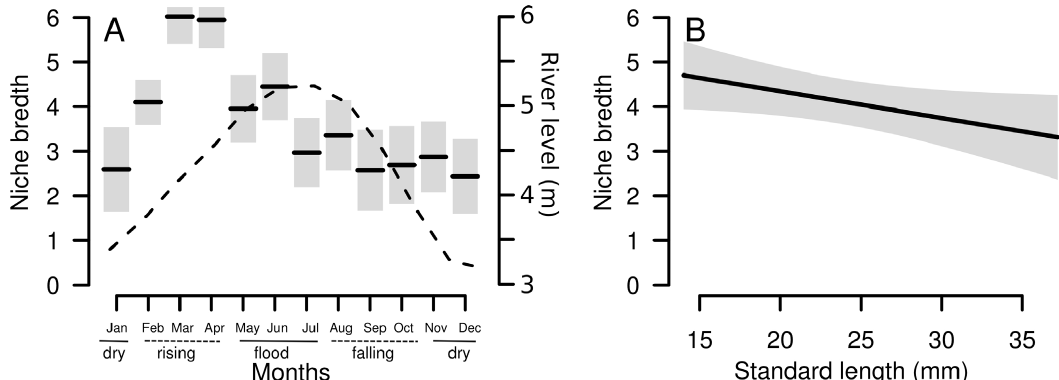
Figure 2. Temporal variation in mean adjusted niche breadth (mean±confidence interval) (A) and adjusted niche breadth (±confidence interval) in response to standard length (mm) (B) of Odontostilbe pequira along a sampled year in the southern Pantanal at Porto Murtinho, MS, Brazil. Doted line represent a historical mean river level of Paraguay